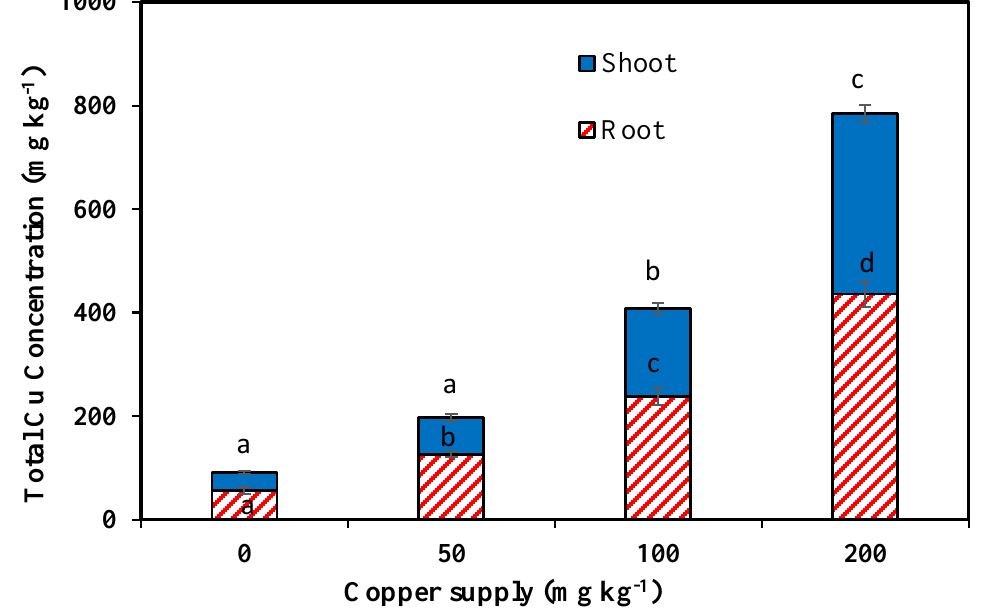
Figure 4. Copper concentration in roots and shoots of Zea mays grown in contaminated soil with 0, 50, 100 and 200 mg kg −1 copper. Mean values that do not share a letter are significantly different at p = 0.05 (mean ± S.E.; n = 3).